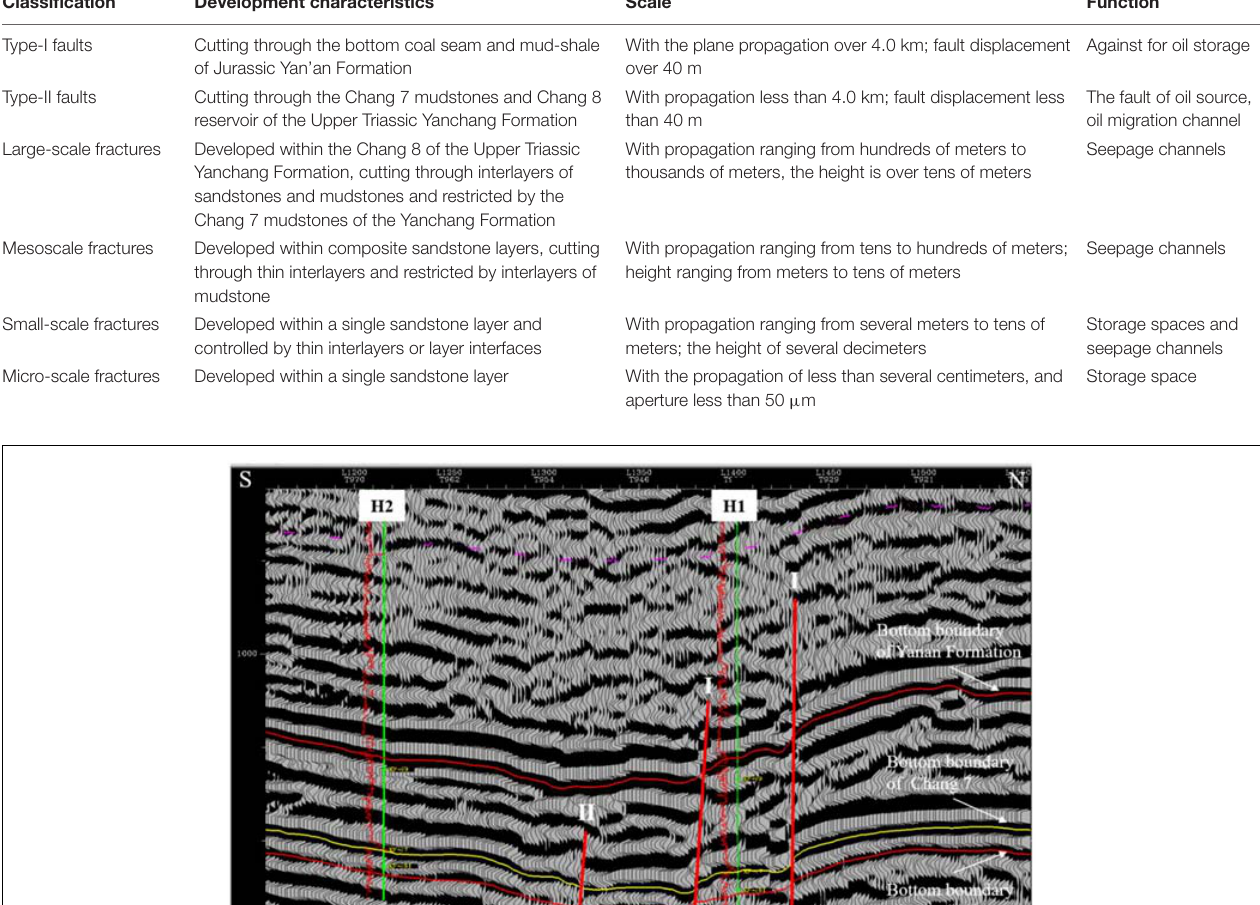
faults on the plane is less than 4.0 km, and their